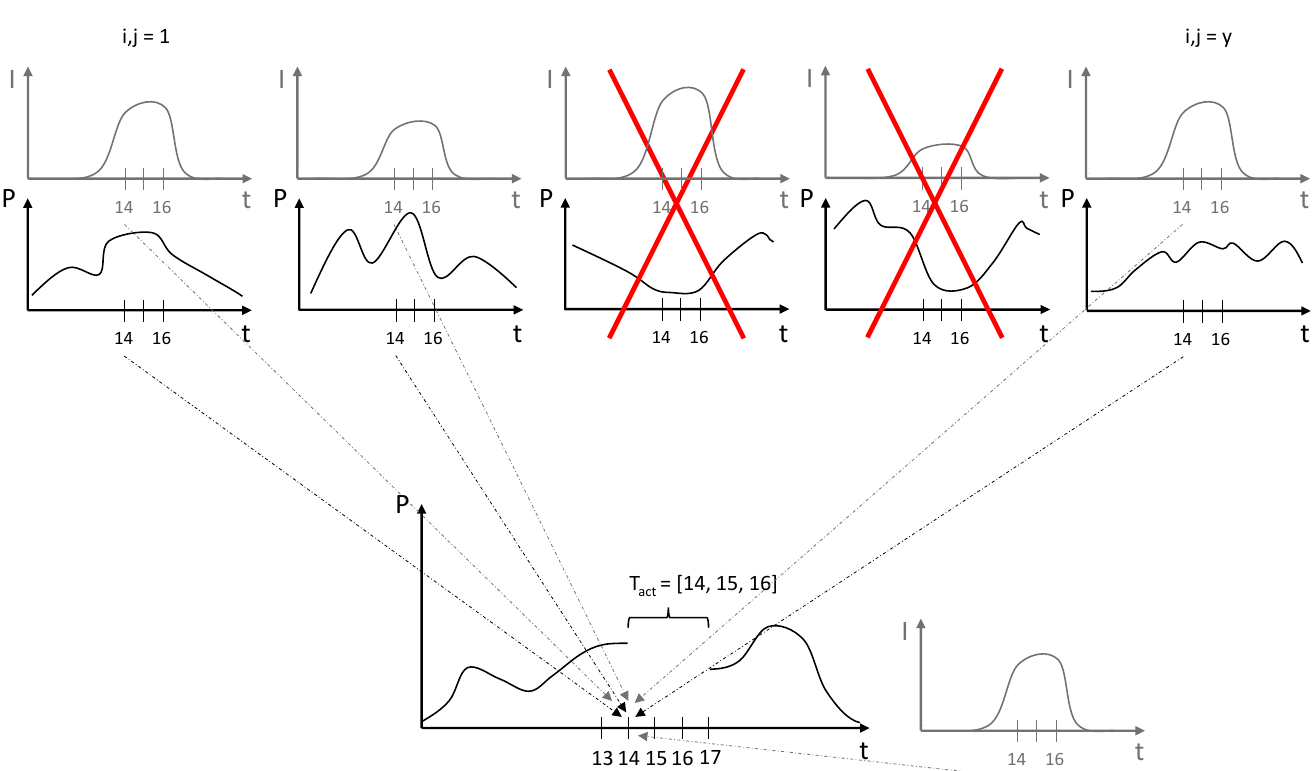
Figure 6. Illustration of baseline IV and its variables. The necessary data for P t is taken per timestep, for the previous y days. The necessary data for I t is taken for the exact same days used for P t . As only x out of y historical days are included, not all historical values are